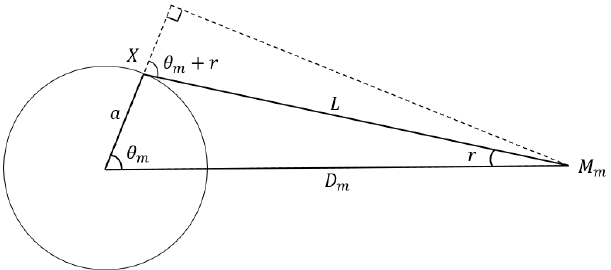
Figure 1. Schematic of the tidal forces generated by the moon, where M m , a , D m , and L are the moon, the radius of the earth, the distance to the moon, and the distance of the moon from any point X on the earth, respectively. θ m is the zenith angle of point X relative to the moon, and r is the angle between the moon pointing to the center of the earth and point